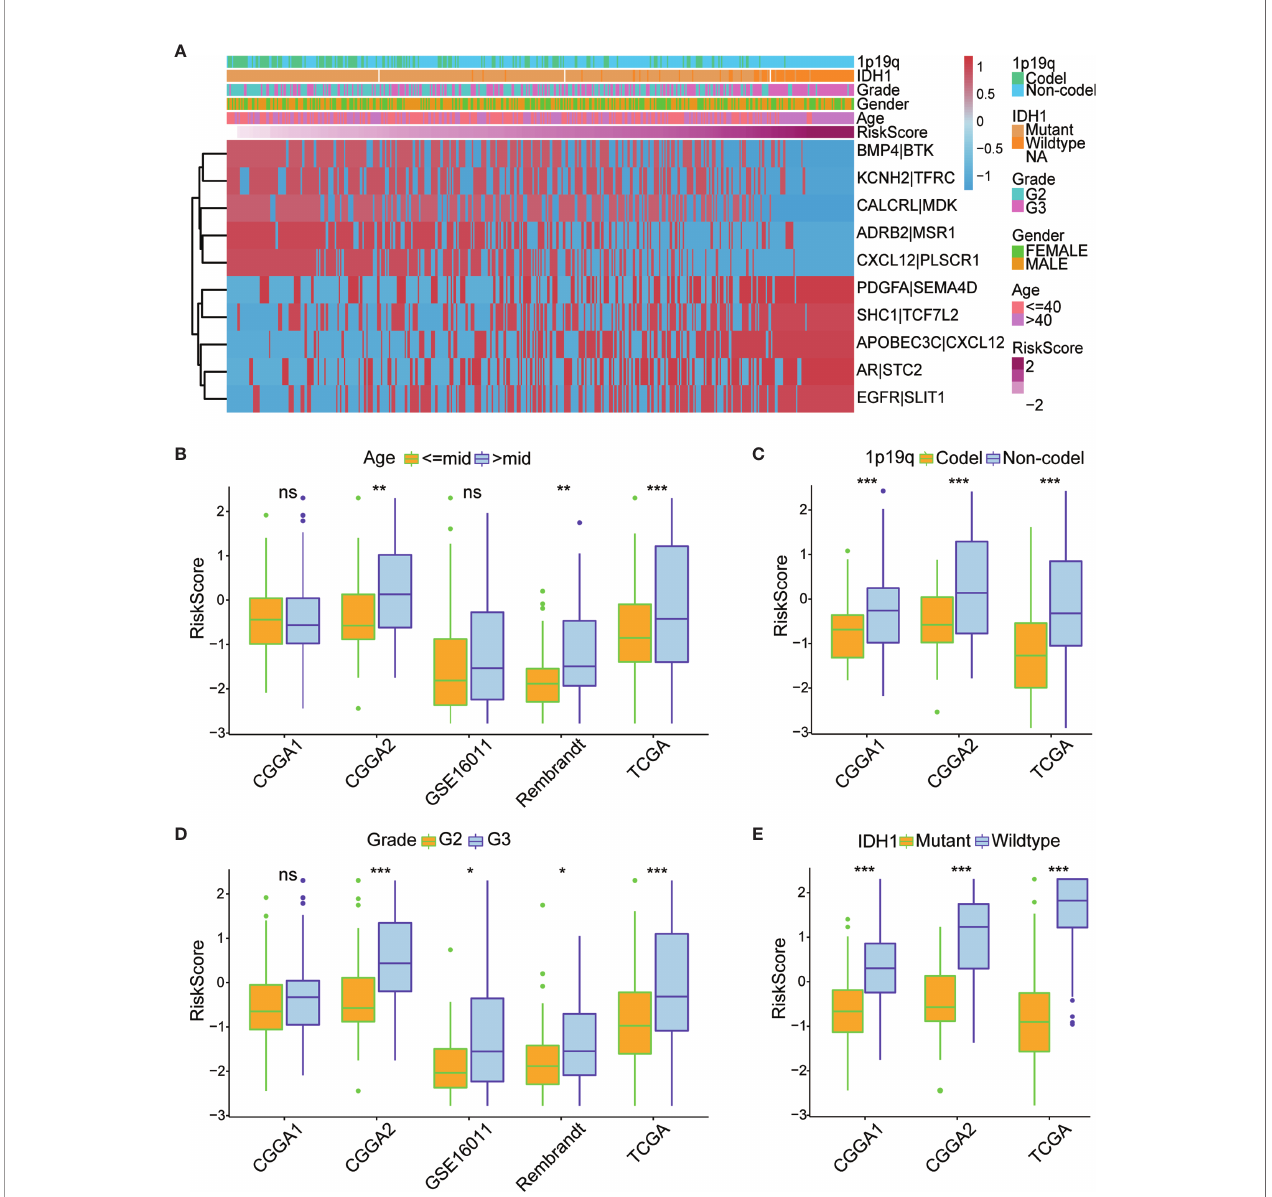
FIGURE 4 | (A) Heatmap of the correlation between the 10 immune-related gene pairs (IRGPs) and the clinicopathological features of The Cancer Genome Atlas (TCGA) dataset. (B – E) Box plots revealed that patients with different clinicopathological features (including age, 1p/19q co-deletion status, WHO grade, and IDH mutation status) had different risk scores between the high- and low-risk subgroups. World Health Organization; IDH, isocitrate dehydrogenase. *P < 0.05, **P < 0.01, ***P < 0.001, ns, no signi fi cant